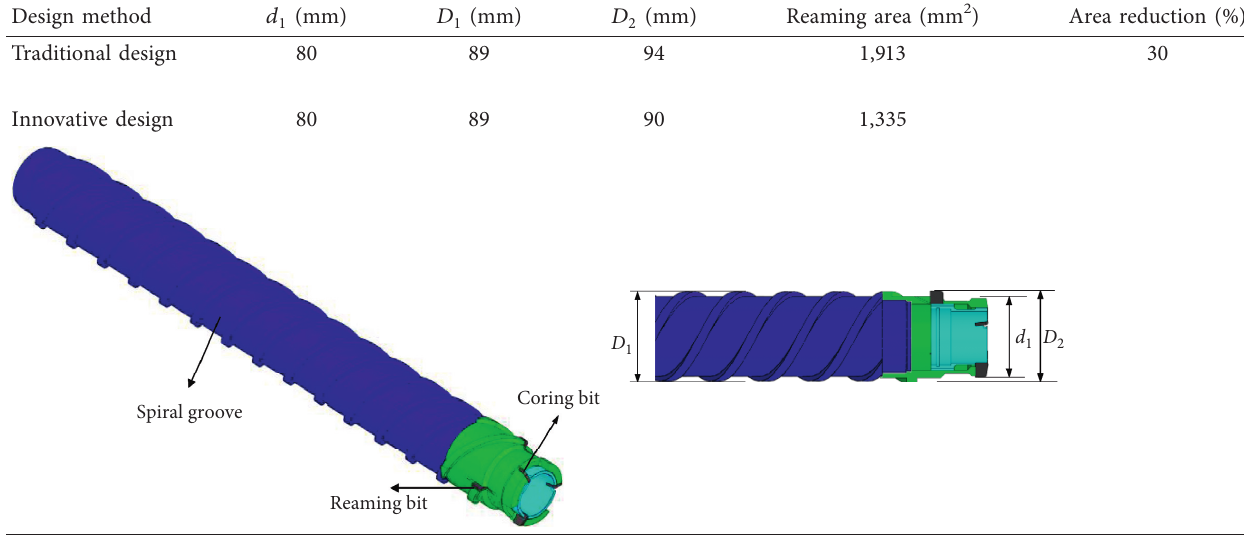
Table 4: Structural parameters of coring bit assembly.